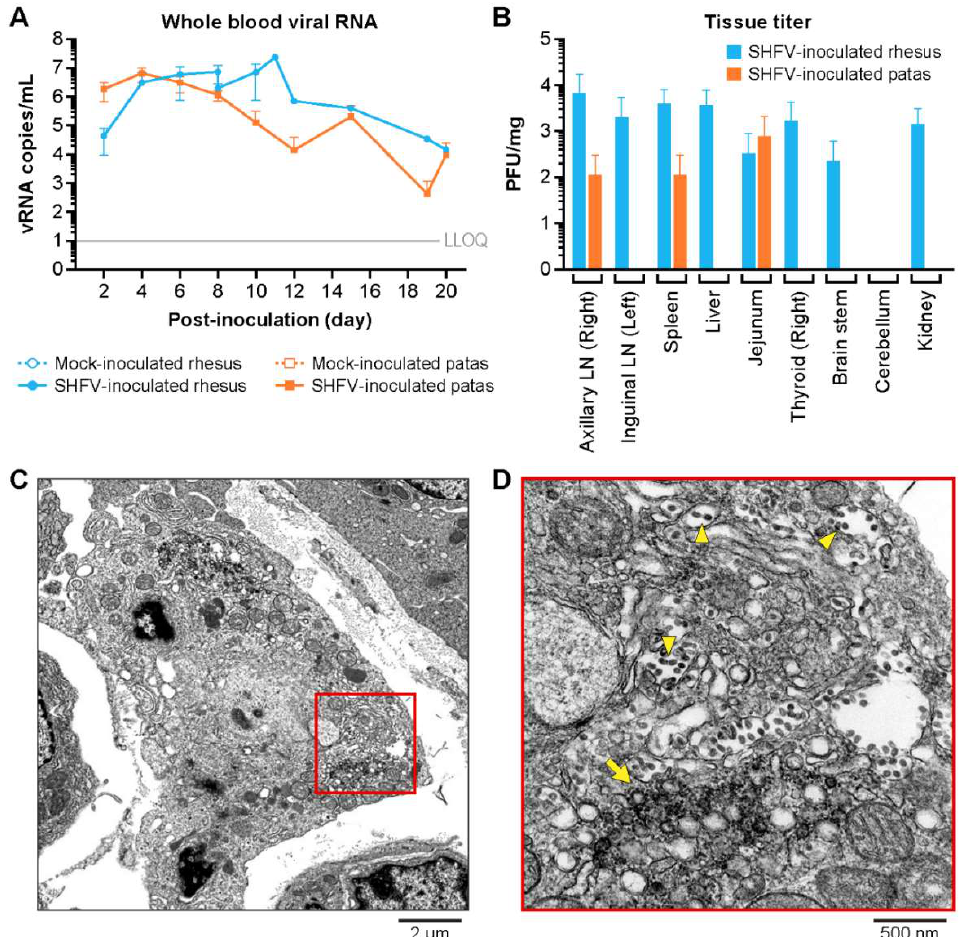
Figure 4. Virological and microscopic evidence of SHFV replication in patas and rhesus monkeys. Mean vRNA copy number values in viral RNA copies per mL of whole blood for mock (open symbols) and SHFV-inoculated (closed symbols) patas monkeys (orange) and rhesus monkeys (blue) ( A ). The mean titer of tissues for SHFV-inoculated patas monkeys (orange) and rhesus monkeys (blue) in PFU per mg of 10% tissue homogenate of lymph nodes (LN), spleen, jejunum, cerebellum, and kidneys ( B ). Electron micrograph of jejunum from a SHFV-inoculated patas monkey showing double-membrane vesicles (DMVs) and apparently mature virions (red box, C). Enlargement of boxed area from ( C ) showing apparently mature virions (yellow arrowheads) and double-membrane vesicles (yellow arrow) ( D ). The error bars represent standard deviation.